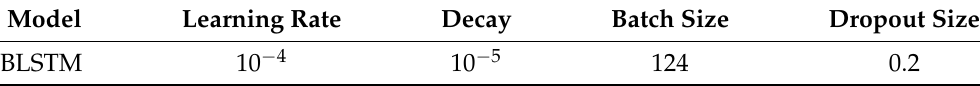
Table 4. Hyperparameters obtained from Bayesian optimization for each